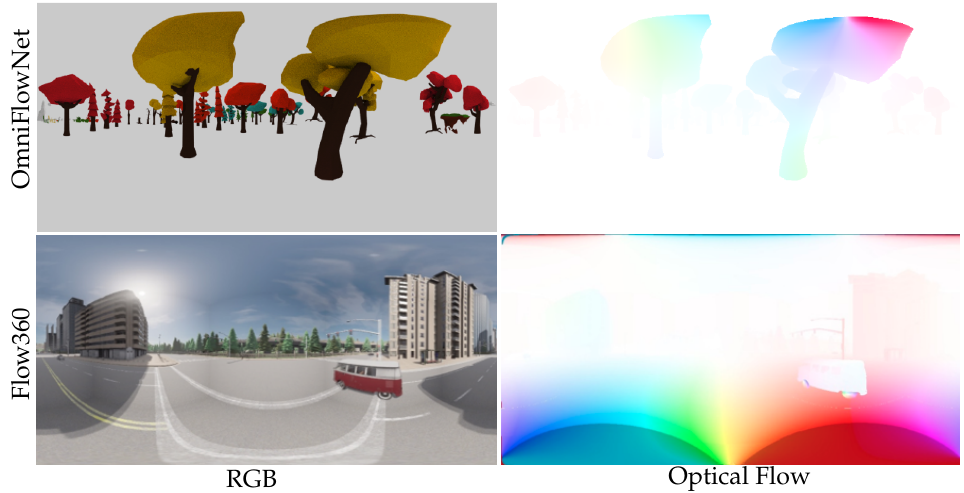
Figure 4. OmniFlowNet [14] and Flow360 [23] datasets. Equirectangular ground-truth optical flow is associated to the RGB images sequence.